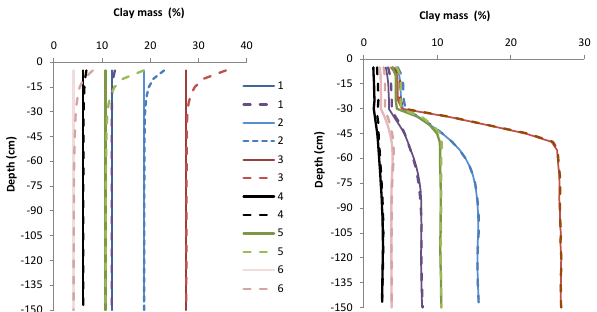
Figure 3. Clay mass fraction (%) evolution as a function of physi- cal weathering (Model A, left panel) and as a function of interactive soil-forming processes (Model B, right panel). Roman numerals 1– 6 represent texture numbers presented in Table 1. Solid lines repre- sent initial textures while broken lines represent evolution of texture as affected by other soil processes i.e., only physical weathering (left hand side) and a combination of mainly physical weathering and clay migration (right hand side). Notice that with only physical weathering allowed (Model A), the initial textures (solid lines) do not change whereas in model B, even the initial textures change due to other processes notably clay